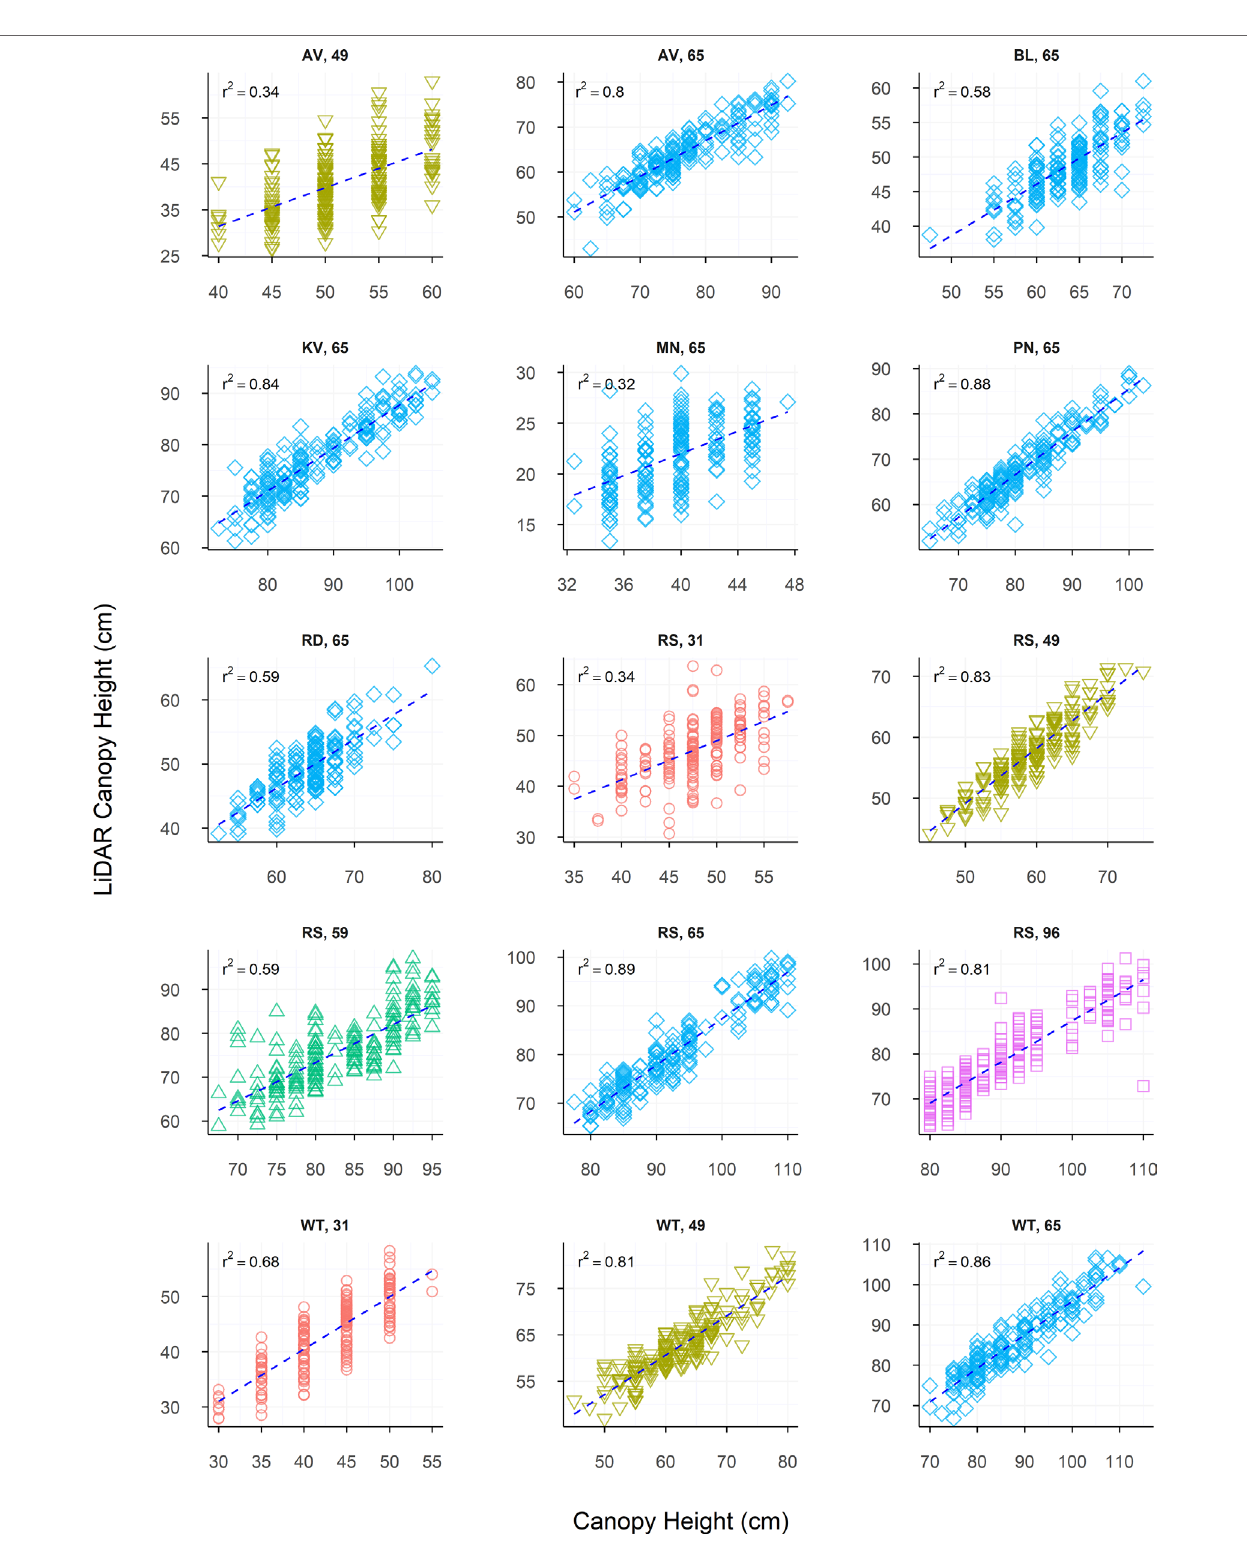
FIGURE 5 | The relationship between LiDAR Canopy Height and Canopy Height, presented individually for each site and sample time (ZGS). Dashed lines indicate the line of best fit, coloured shapes indicate measurements collected at Zadoks growth scales (ZGS) as follows, red circles at ZGS 31, yellow triangles at ZGS 49, green triangles at ZGS 59, blue diamonds at ZGS 65 and pink squares at ZGS